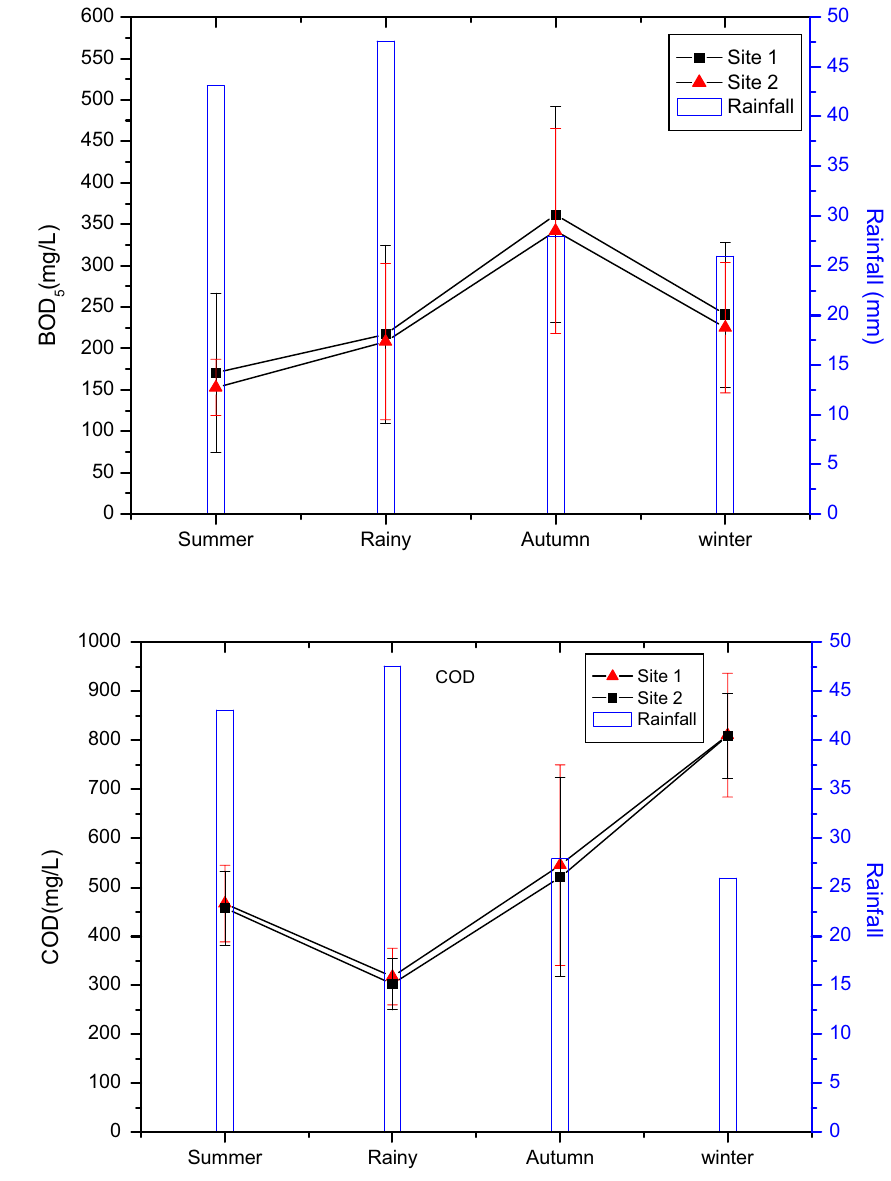
Fig. 6 Average seasonal variations of biological oxygen demand (BOD) at different sea-